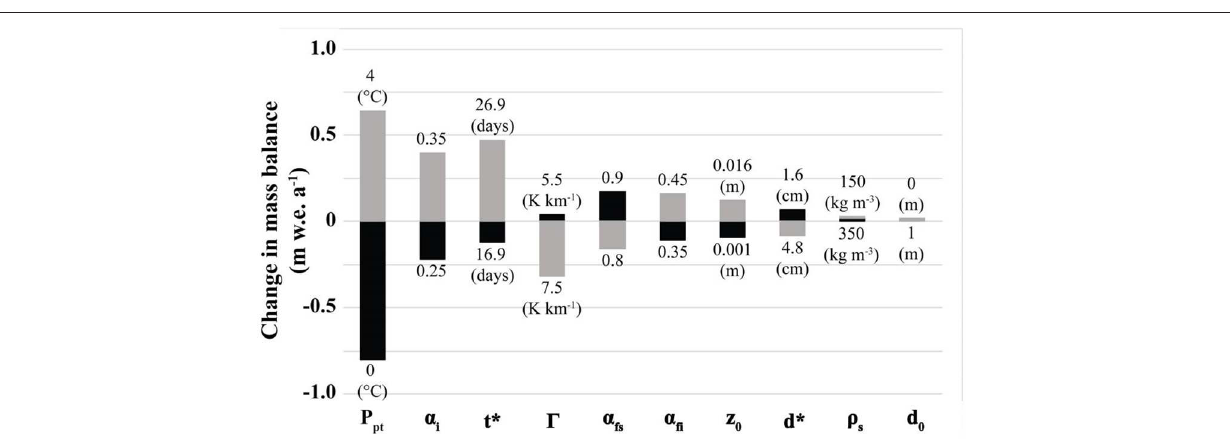
FIGURE 4 | Results from testing glacier mass balance sensitivity to input parameter values. Gray bars represent increased parameter values (relative to the defaults), while black bars represent decreased parameter values. The range of parameter values tested is included above and below each bar. See Table S1 for default parameter